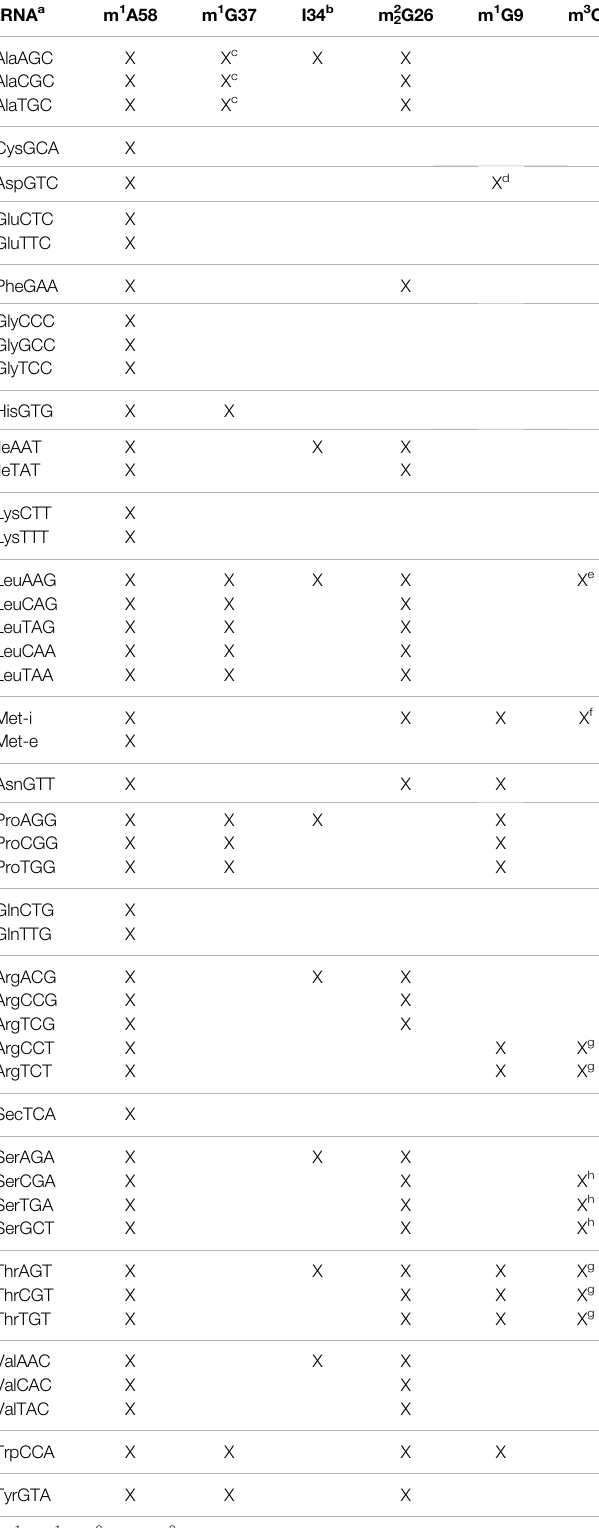
TABLE 2 | Modi fi cations identi fi ed in the Chlorocebus sabaeus tRNAome. tRNA a m 1